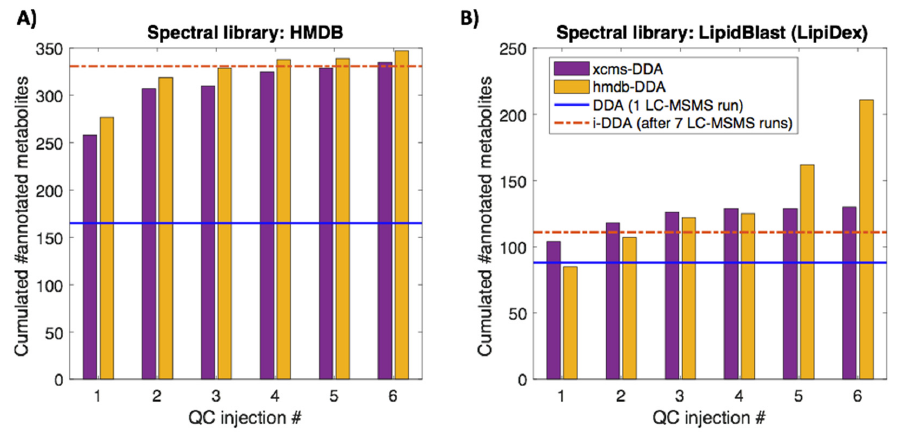
Figure 4. Number of annotated features in the sample batch using the HMDB ( A ) or LipidBlast ( B ) spectral libraries and MS 2 spectra acquisition using DDA, i-DDA, xcms-DDA or hmdb-DDA.